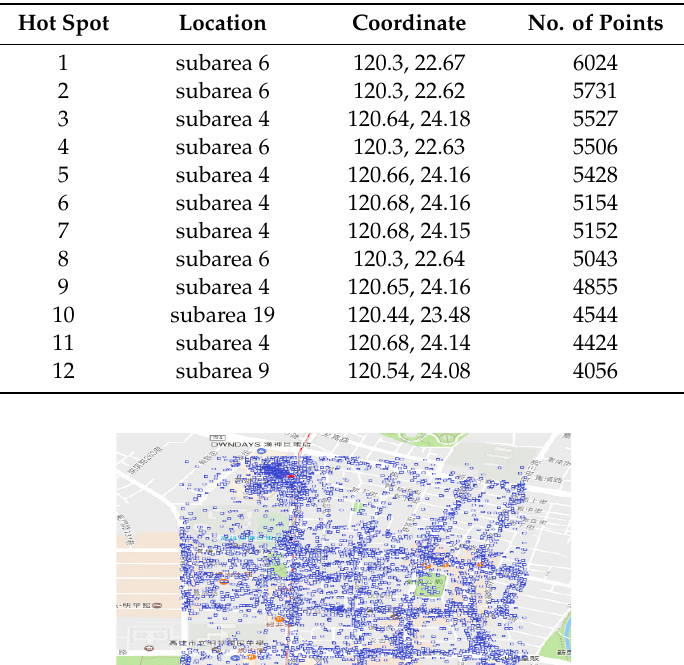
Table 5. The first 12 hot spots.